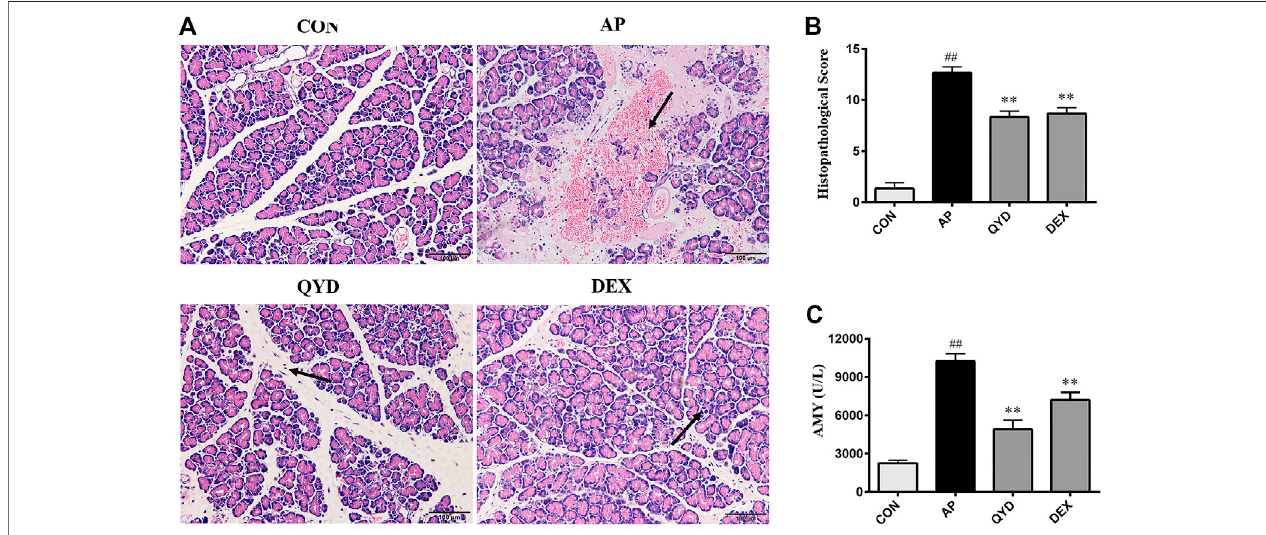
FIGURE 6 | Histopathological examination and biochemical analysis. (A) Histopathological observation of pancreatic tissue in four groups (HE, × 200); (B) Histological score of pancreatic tissue in four groups (HE, × 200). (C) Serum amylase level in rats. Data are presented as the mean ± SD ( n (cid:2) 3), ** p < 0.01 vs. AP group. ## p < 0.01 vs. CON group.